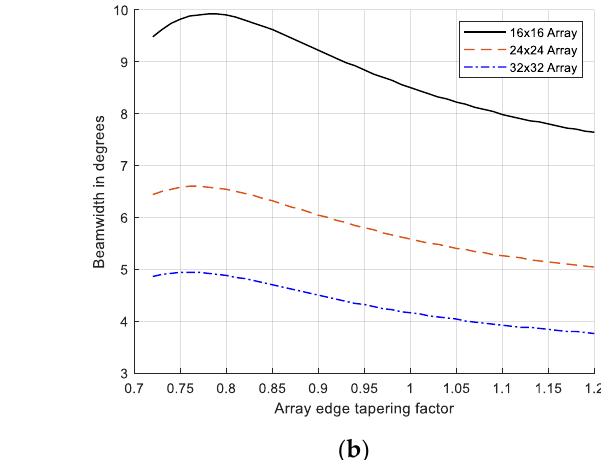
Figure 10. ( a ) Optimizing radial tapered cosine-square window at different array sizes. ( b ) Beam- width variation with the array edge tapering factor at different array sizes.